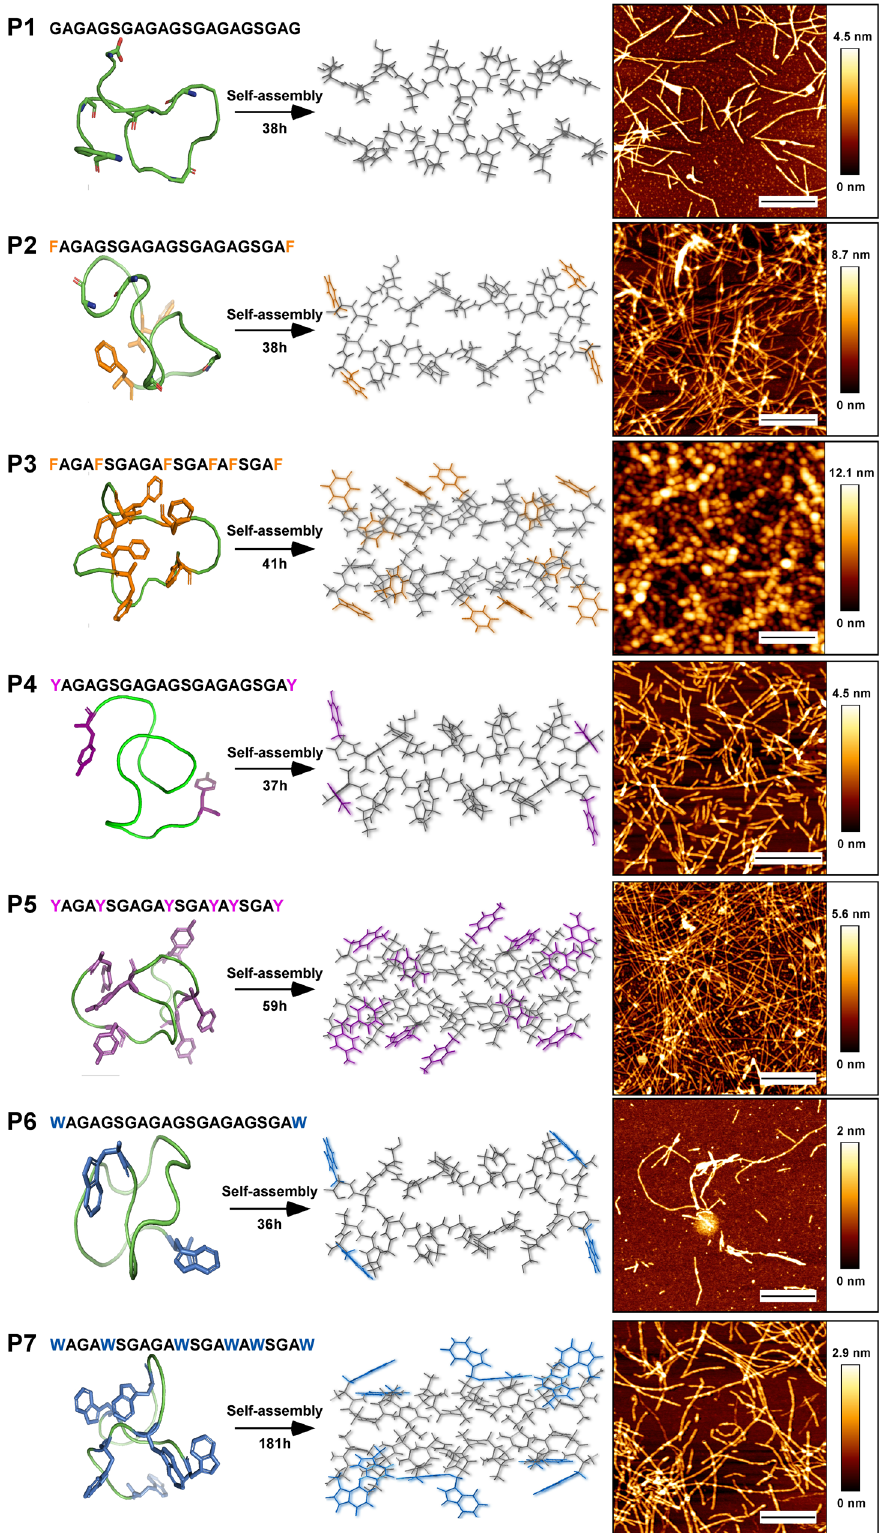
Fig. 2 P1-P7 peptides ’ supramolecular fi brillar self-assemblies. (P1) in which G is substituted with F in (P2), Y in (P4), or W in (P6) aromatic amino acids (with 10% substitution) and when the fraction of F (P3), Y (P5), and W (P7) was increased to 30%. The peptide structure (left column) was predicted using PEP-FOLD3 software (shown in ribbon and stick formats) 65 . The interaction between two peptide molecules schematically shown in the central column. From our experimental results, we observed that in all the cases the hydrophobic residues face an external part. The morphology of the self- assembled peptides, determined by AFM (the right panel), indicates the existence of polymorphism. The scale bars for AFM images are 500